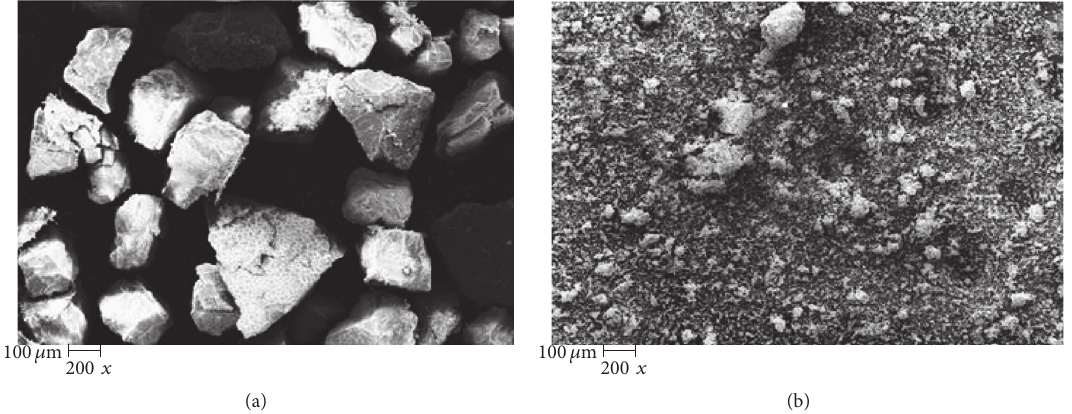
Figure 4: SEM images for natural quail eggshell ((a) and (b)) and calcined quail eggshell, with an increase of